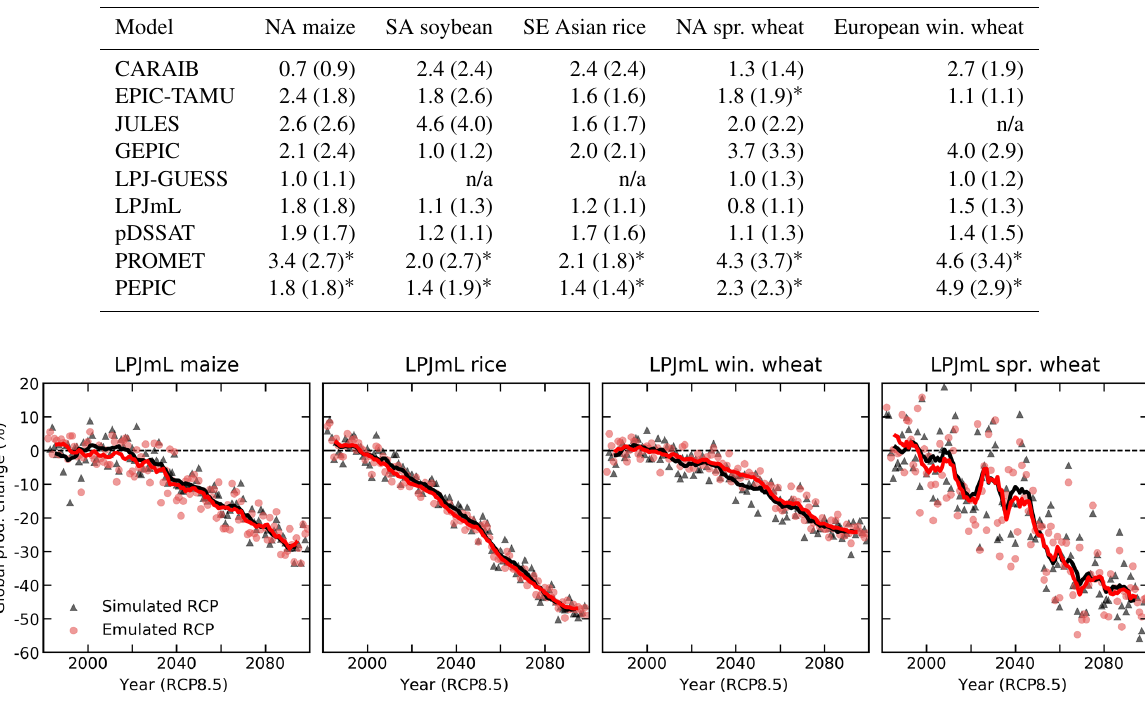
Figure 9. Test of emulator performance in reproducing yield simulations made with a realistic climate projection. Panels show simulated (black) and emulated (red) global production for four crops from the LPJmL model, driven with temperature and precipitation outputs from the HadGEM2-ES climate model for the RCP8.5 scenario. In both cases, nitrogen and CO 2 are held fixed, at 200kgha − 1 and 360ppm. Points show yearly global production change from the 1981–2010 baseline, and lines show a 10-year running mean. See text for discussion of relating the HadGEM2-ES temperature time series to the appropriate offset used in emulation. Emulators trained on uniform climatological offsets reproduce well the simulated production response under a realistic climate scenario: yields at the end of the century match to within